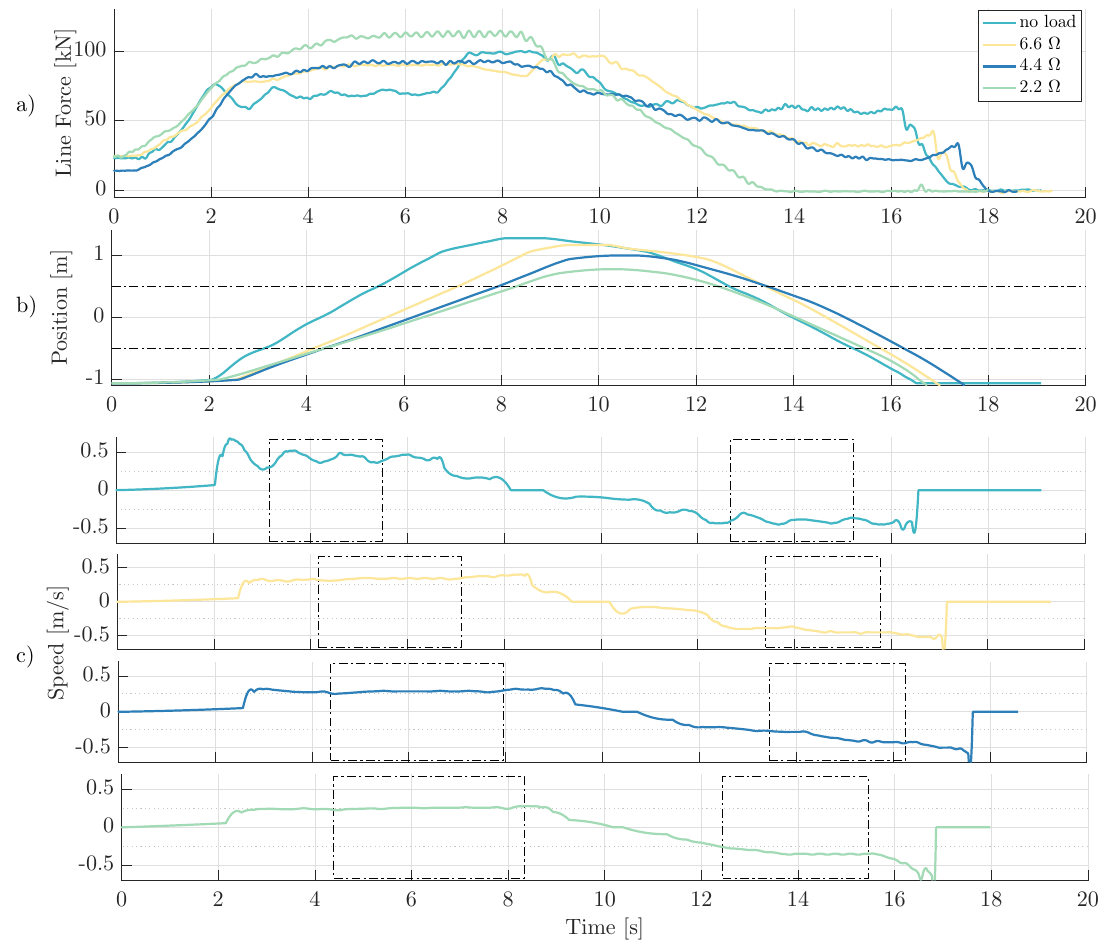
Figure 3. Measured line force ( a ), translator position ( b ) and translator speed ( c ) in time domain for the high speed tests. Dotted areas mark out full active area.